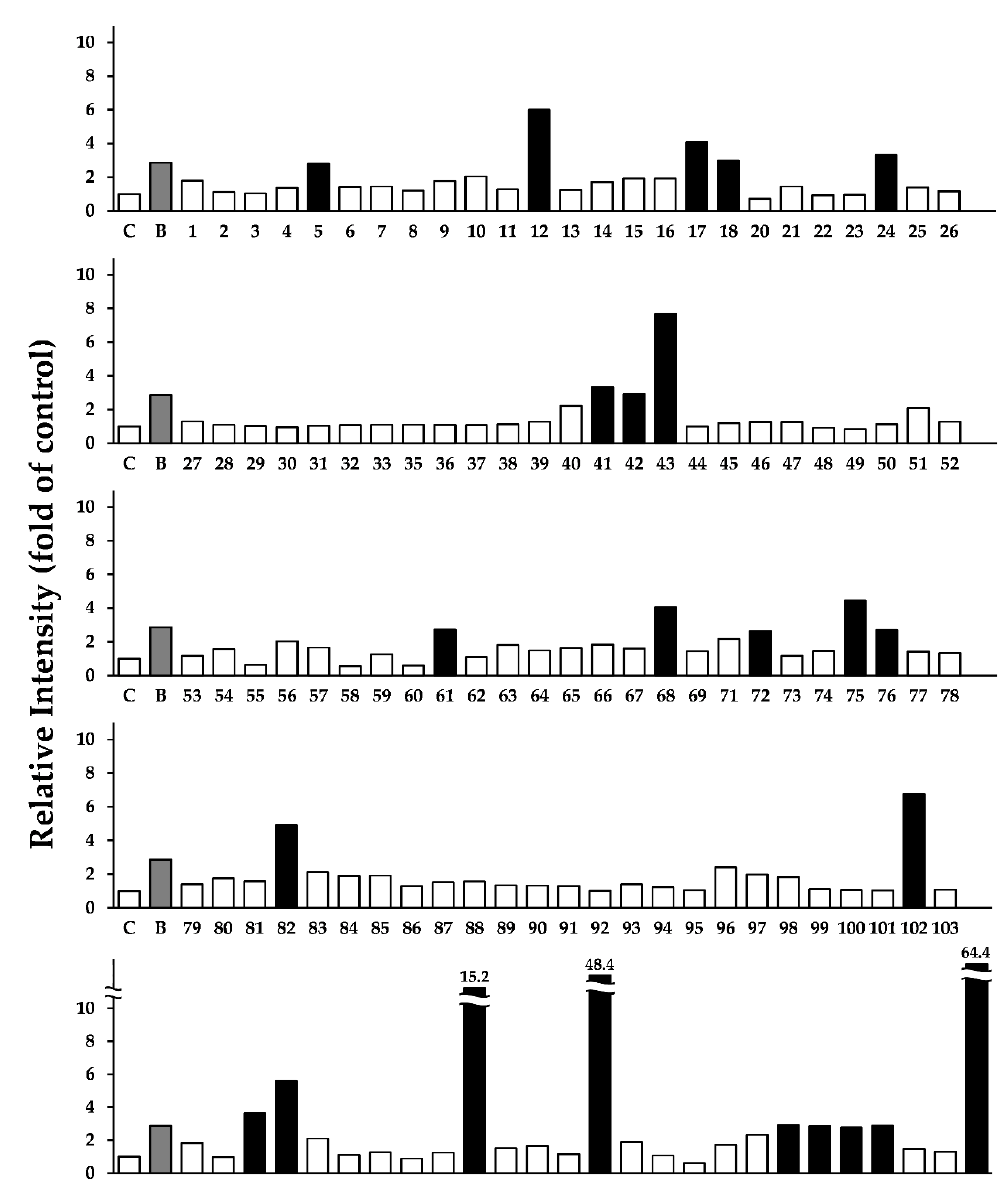
Figure 1. Relative intensity of LC3-II protein levels by the approximately 130 kinds of crude extracts. The noticeable increase is shown in the black column. HepG2 cells were treated with 20 µ g / mL of each crude extract for 24 h, and the LC3-II expression levels were determined using Western blotting. The data shown are representative of three independent treatments with similar results. Notes: C,